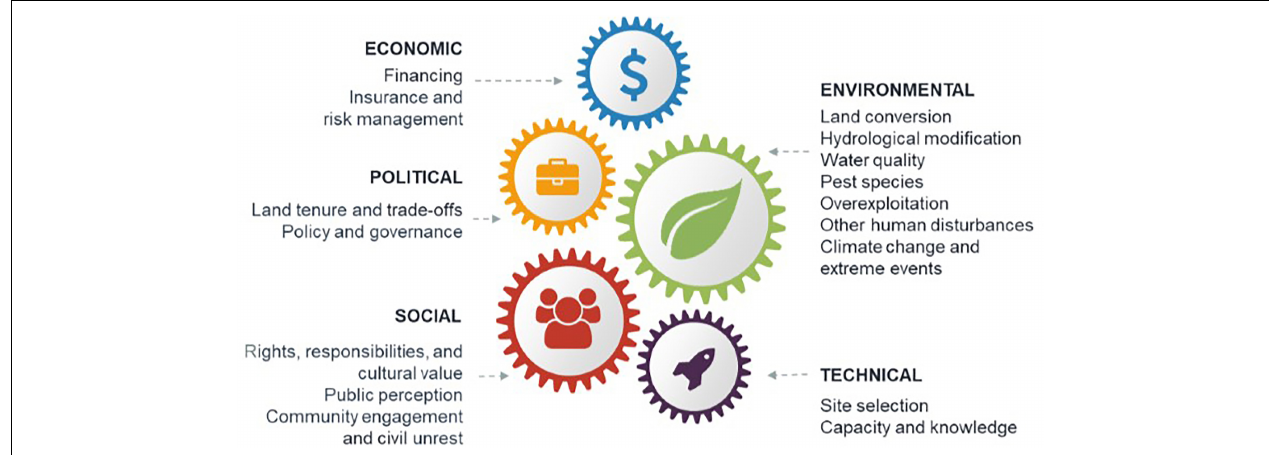
FIGURE 1 | Common barriers to successful blue restoration. Barriers are shown for the restoration of saltmarsh, mangroves, seagrass, shellfish reefs, coral reefs, and